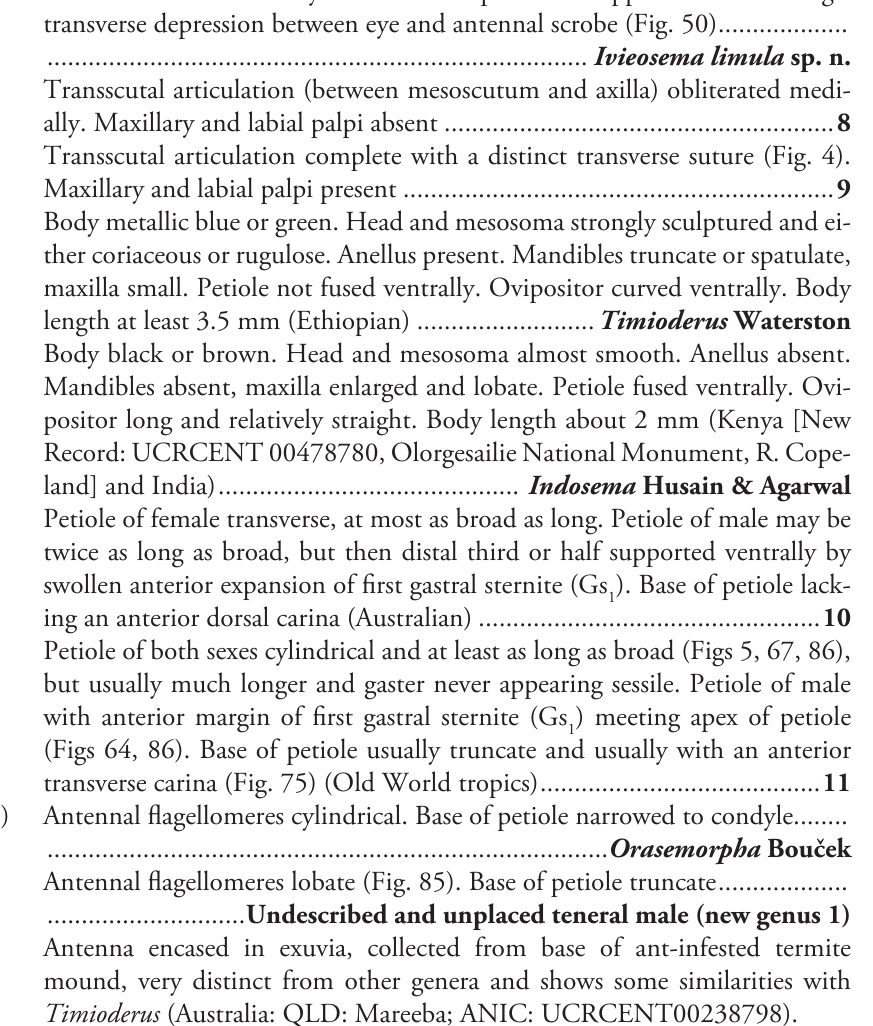
Face smooth to shallowly reticulate. Scape white. Upper frons with single transverse depression between eye and antennal scrobe (Fig. 50) ................... 7 (3) Transscutal articulation (between mesoscutum and axilla) obliterated medi- ally. Maxillary and labial palpi absent ......................................................... 8 – Transscutal articulation complete with a distinct transverse suture (Fig. 4). Maxillary and labial palpi present ............................................................... 9 8 (7) Body metallic blue or green. Head and mesosoma strongly sculptured and ei- ther coriaceous or rugulose. Anellus present. Mandibles truncate or spatulate, maxilla small. Petiole not fused ventrally. Ovipositor curved ventrally. Body length at least 3.5 mm (Ethiopian) .......................... Timioderus Waterston – Body black or brown. Head and mesosoma almost smooth. Anellus absent. Mandibles absent, maxilla enlarged and lobate. Petiole fused ventrally. Ovi- positor long and relatively straight. Body length about 2 mm (Kenya [New Record: UCRCENT 00478780, Olorgesailie National Monument, R. Cope- land] and India) ............................................ Indosema Husain & Agarwal 9 (7) Petiole of female transverse, at most as broad as long. Petiole of male may be twice as long as broad, but then distal third or half supported ventrally by swollen anterior expansion of first gastral sternite (Gs ). Base of petiole lack- 1 ing an anterior dorsal carina (Australian) .................................................. 10 – Petiole of both sexes cylindrical and at least as long as broad (Figs 5, 67, 86), but usually much longer and gaster never appearing sessile. Petiole of male with anterior margin of first gastral sternite (Gs ) meeting apex of petiole 1 (Figs 64, 86). Base of petiole usually truncate and usually with an anterior transverse carina (Fig. 75) (Old World tropics) ......................................... 11 10 (9) Antennal flagellomeres cylindrical. Base of petiole narrowed to condyle ........ .................................................................................. Orasemorpha Bouček – Antennal flagellomeres lobate (Fig. 85). Base of petiole truncate ................... ............................. Undescribed and unplaced teneral male (new genus 1) Antenna encased in exuvia, collected from base of ant-infested termite mound, very distinct from other genera and shows some similarities with Timioderus (Australia: QLD: Mareeba; ANIC: UCRCENT00238798). 11 (9) Lower face lateral to clypeus finely reticulate (Fig. 29). Frenum and propo- deum evenly sculptured, propodeum lacking a distinctly differentiated nar- row median band of areolate sculpture. Prepectus evenly reticulate or rugose, dorsal margin without a raised rim and overlapped by ventral margin of mes- oscutum. Callus at most with a few minute setae. Female antenna with 7–8 funiculars, male with 7–9 funiculars. Ventral valve of ovipositor with several minute lateral teeth (Fig. 35) ........................................................................ ........................... Hayatosema gen. n. ( assectator -group of Heraty, 1994) – Face variously sculptured, but if finely reticulate then propodeum with dis- tinctly differentiated median channel (Fig. 11), prepectus broadly foveate with a distinctly raised dorsal margin (Fig. 12) or callus with dense patch